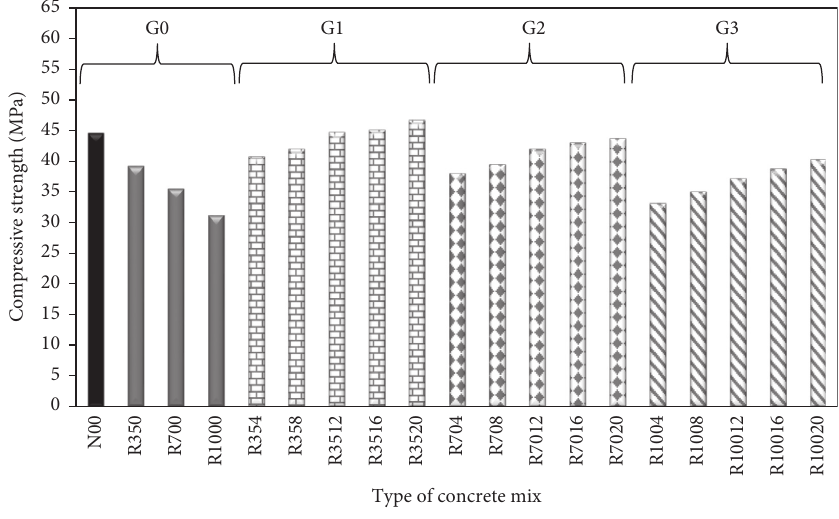
Figure 8: Compressive strength of all mixes at age of 28 days.